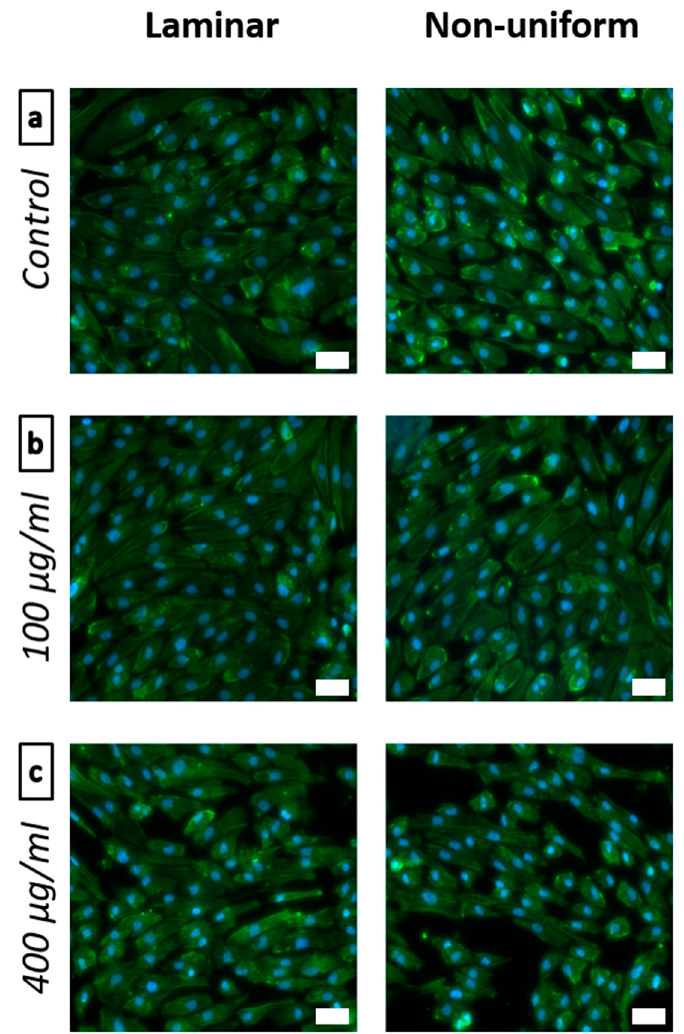
Figure 5. Effects of circulating polyR-Fe 3 O 4 on enthodelial cell grown under flow conditions. HUVECs were grown in bifurcating slides until confluence and perfused with polyR-Fe 3 O 4 -containing medium for 18 h. The representative laminar and non-uniform regions are shown after fluorescent staining. Nuclei are visualized using a Hoechst 33342 (blue) staining, whereas F-actin is visualized with Alexa 488-conjugated phalloidin (green). Representative images of n = 3 experiments are shown. (Scale bars: 50 µm).